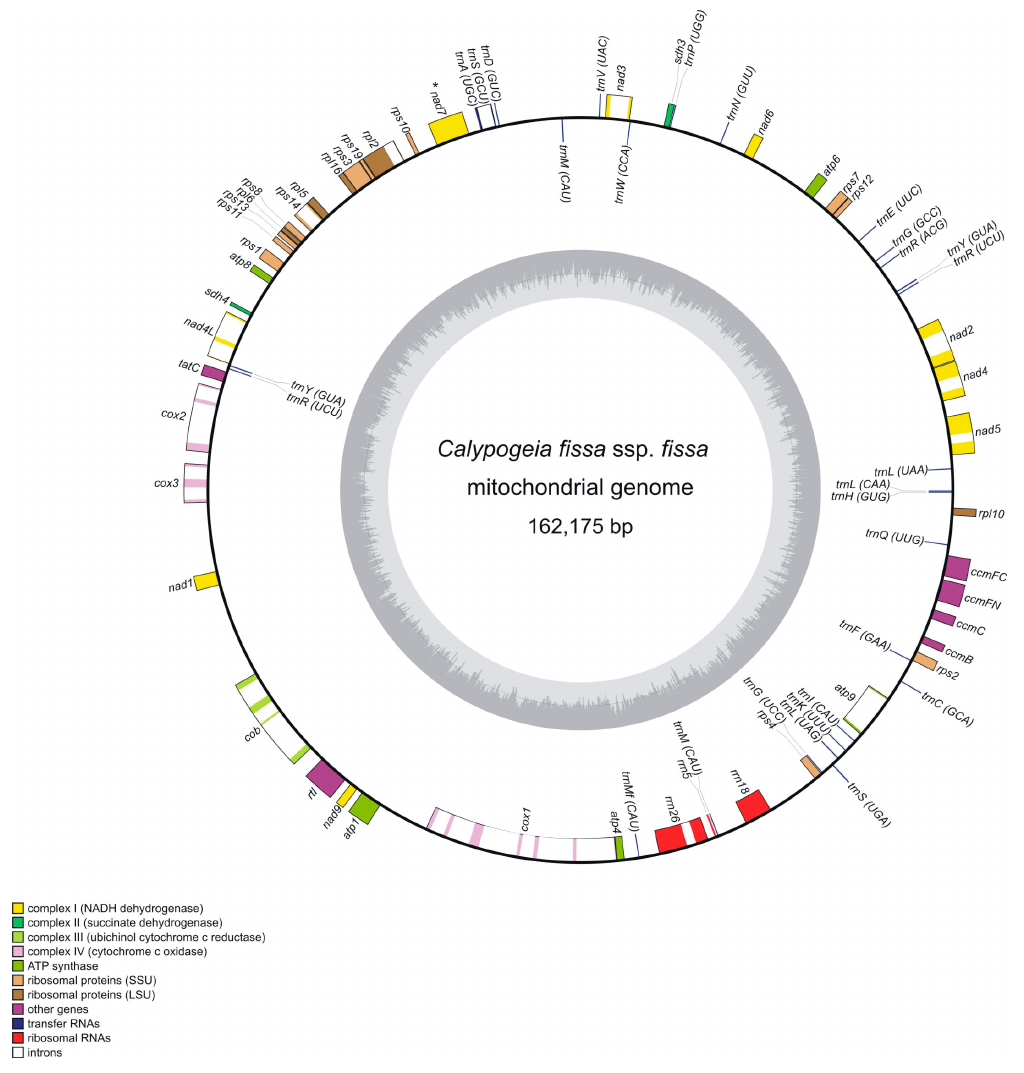
Figure 1. Gene map of the mitogenome of Calypogeia fissa ssp . fissa . Genes inside and outside the outer circle are transcribed in counterclockwise and clockwise directions, respectively. The genes are color-coded based on their function. The inner circle visualizes the G/C content. Pseudogenes have been marked with an asterisk.